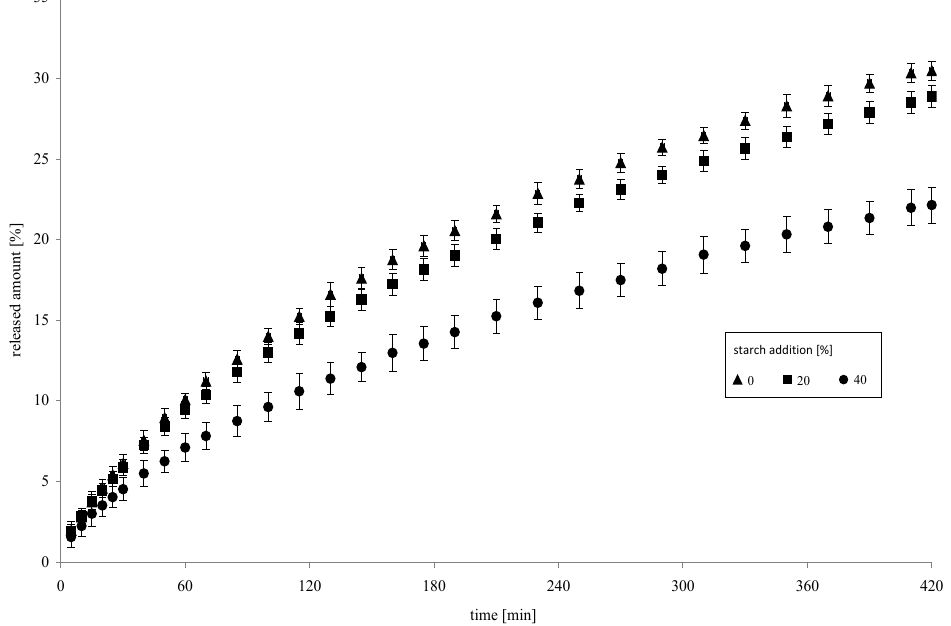
Figure 8. Dynamics of a model drug release from a hydrogel containing modified starch.